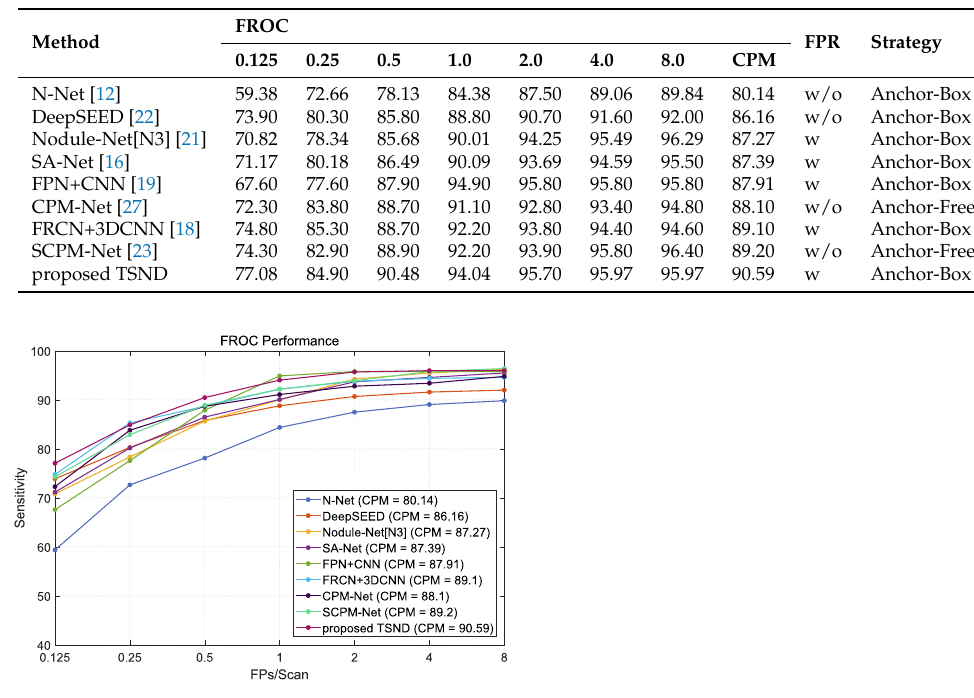
Figure 13. The comparison of FROC curves between other state-of-the-art methods and our proposed two-stage nodule detection (TSND)